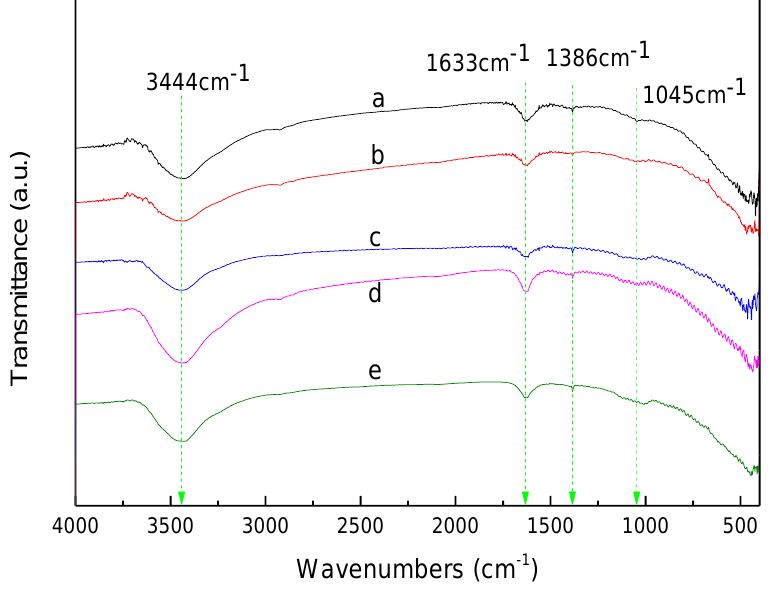
Figure 6. FTIR transmission spectra of ZnS ( a ), Al-ZnS ( b ), Al-ZG0.6 ( c ), Al-ZG1.2 ( d ) and Al-ZG1.8 ( e ).